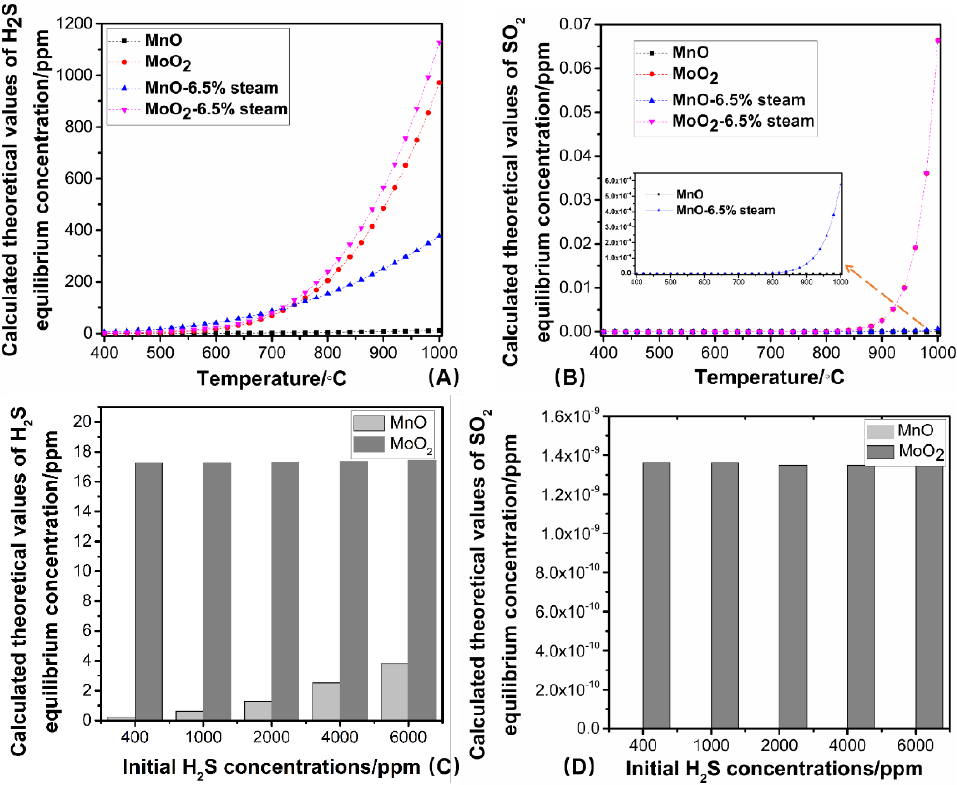
Figure 1. Theoretically calculated equilibrium concentrations with different inputs. ( A , B ): Equilibrium sulfur concentrations of MnO and MoO 2 under dry or steam environments at different temperatures, ( A ): H 2 S, ( B ): SO 2 ; ( C , D ): Equilibrium sulfur concentration of with different initial H 2 S concentrations at 600 °C, ( C ): H 2 S, ( D ): SO 2 .